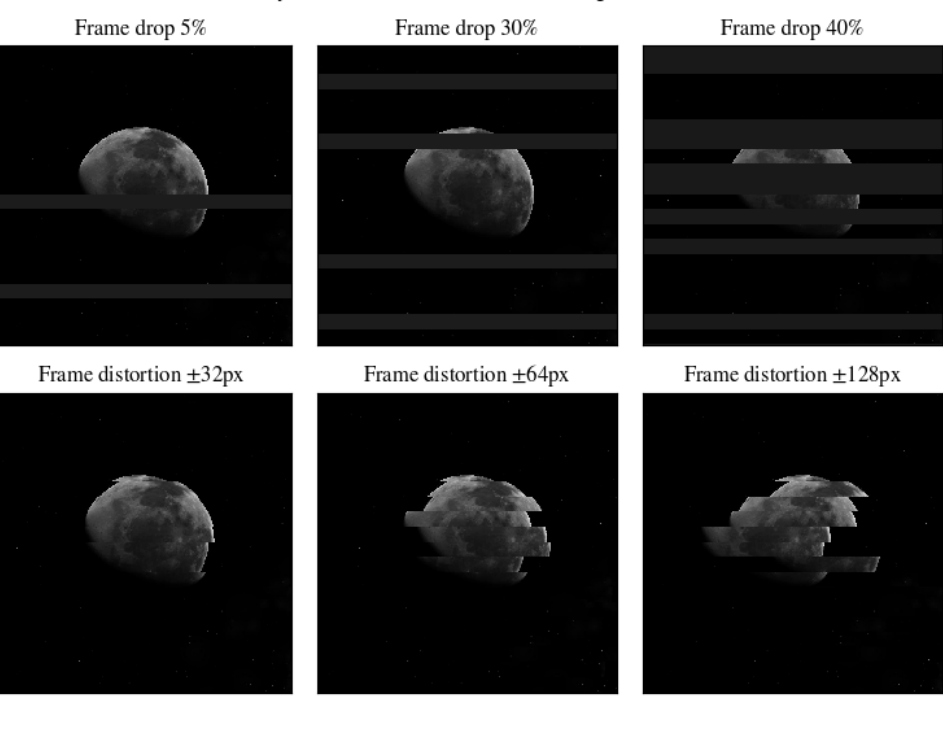
Figure 7. Images altered by various sources of noise.